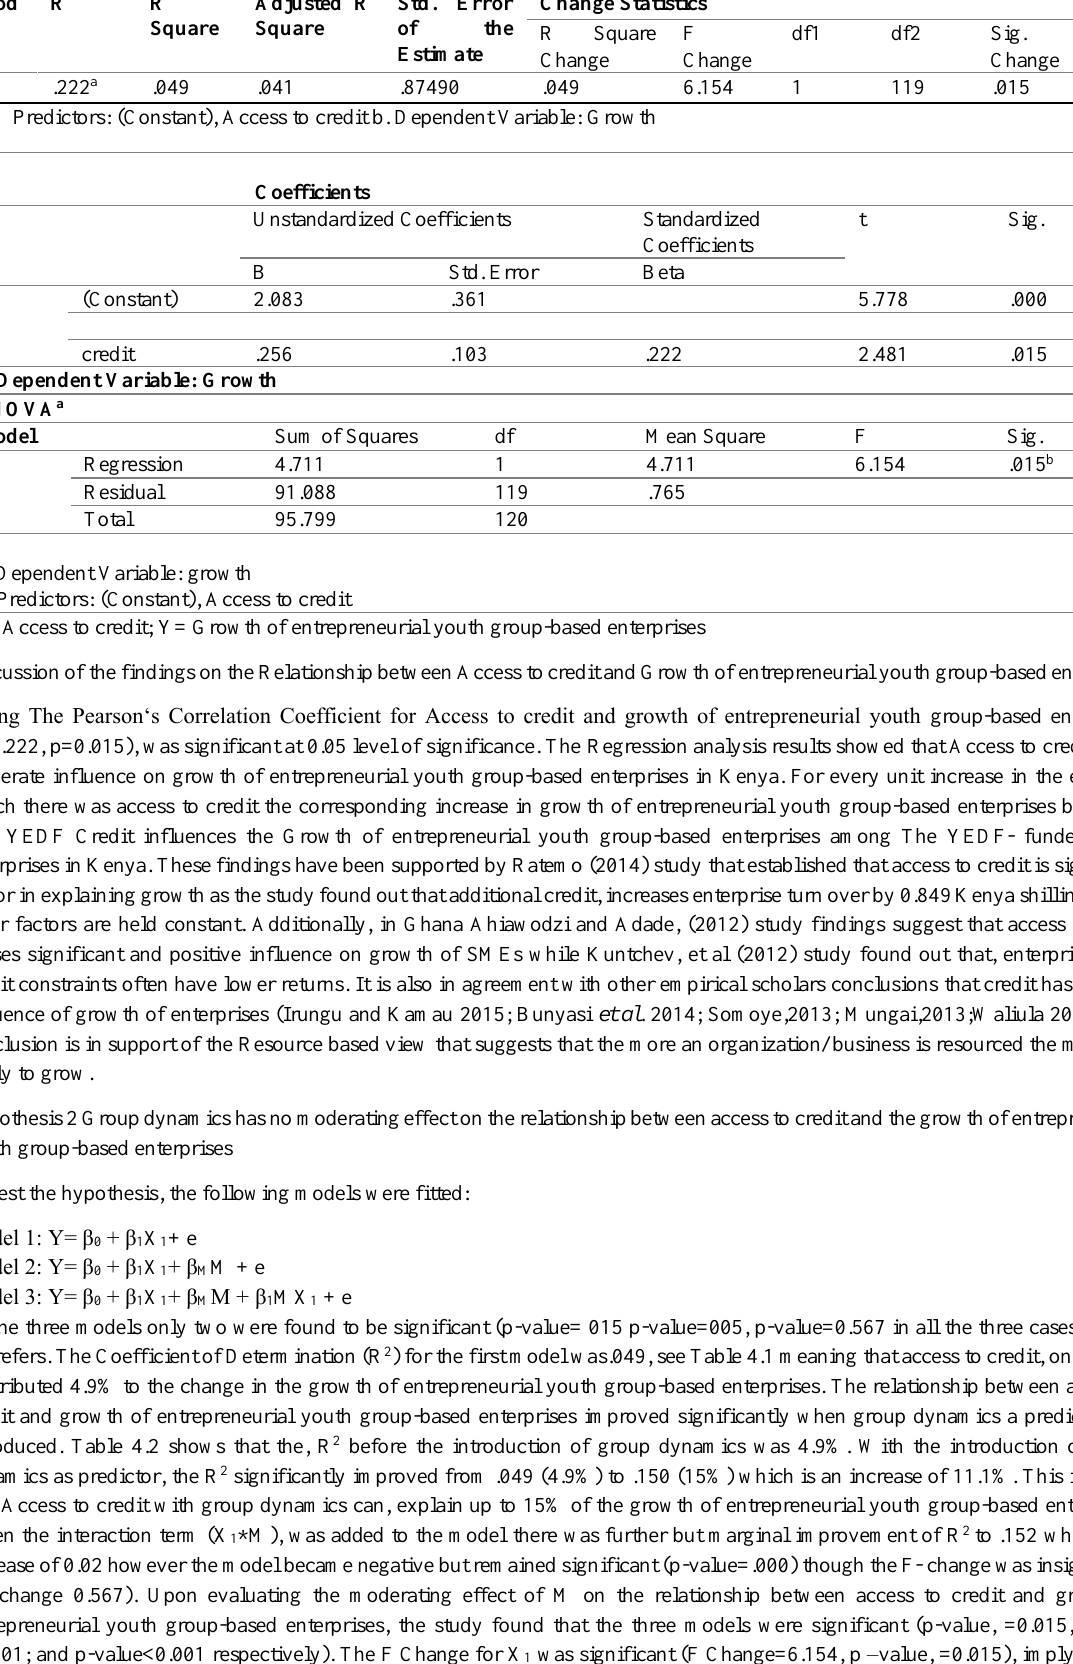
Table 2: The relationship between Access to credit and Growth of entrepreneurial youth group-based enterprises Model Summary